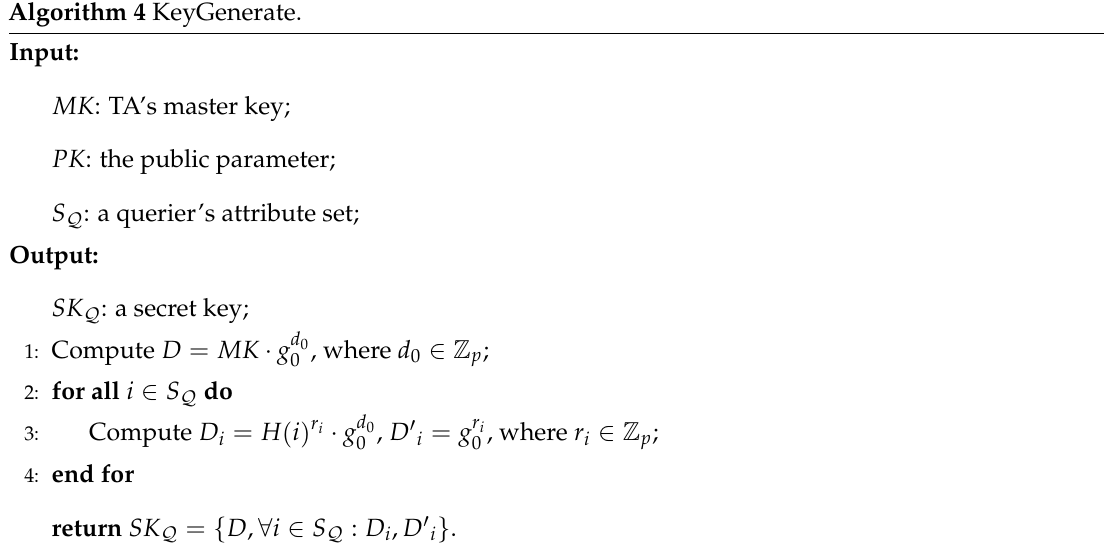
Algorithm 4 KeyGenerate.